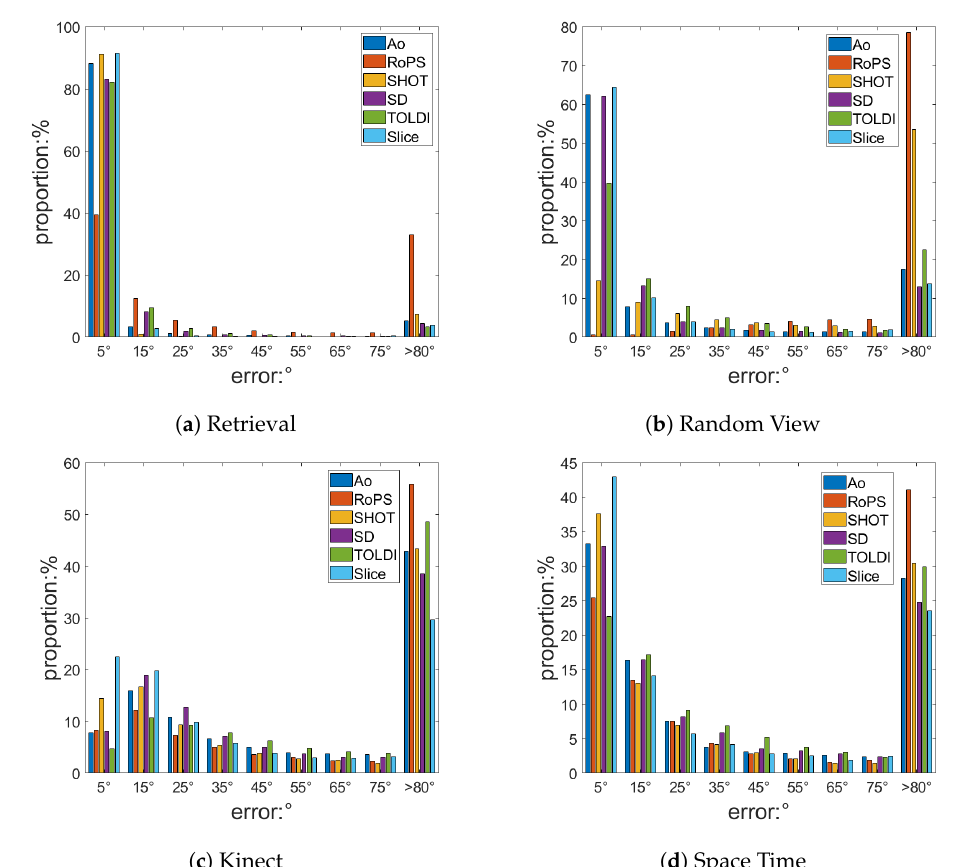
Figure 8. The repeatability results. The X-axis represents different error levels, and the Y-axis represents the distribution proportions under these error